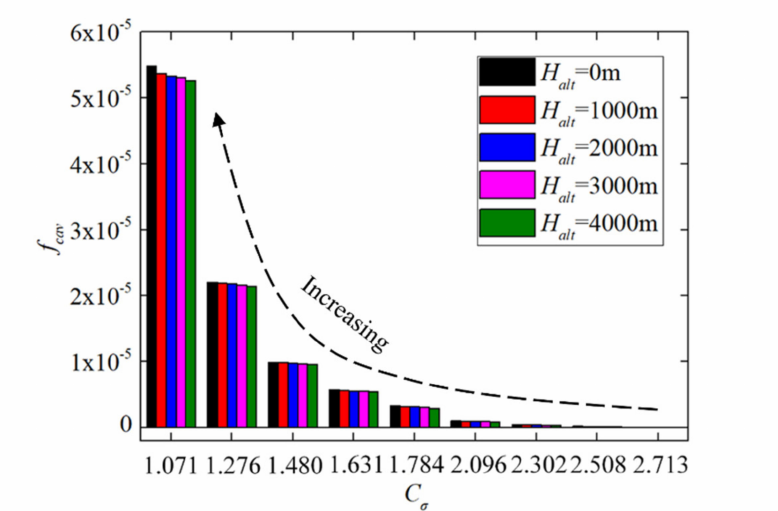
Figure 4. Comparison of cavitation vapor proportion f cav among different H alt at different C σ